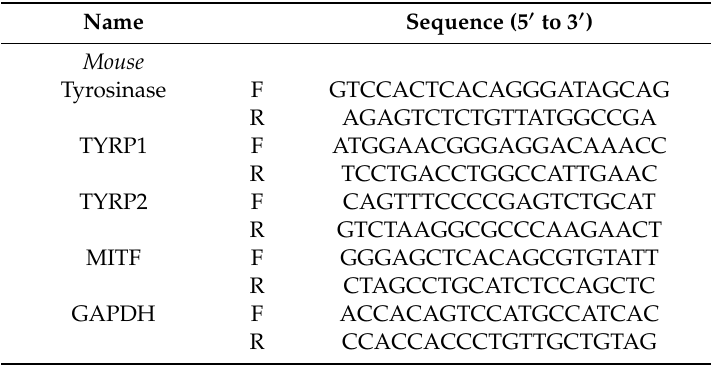
Table 1. Polymerase chain reaction (PCR) primers used in this